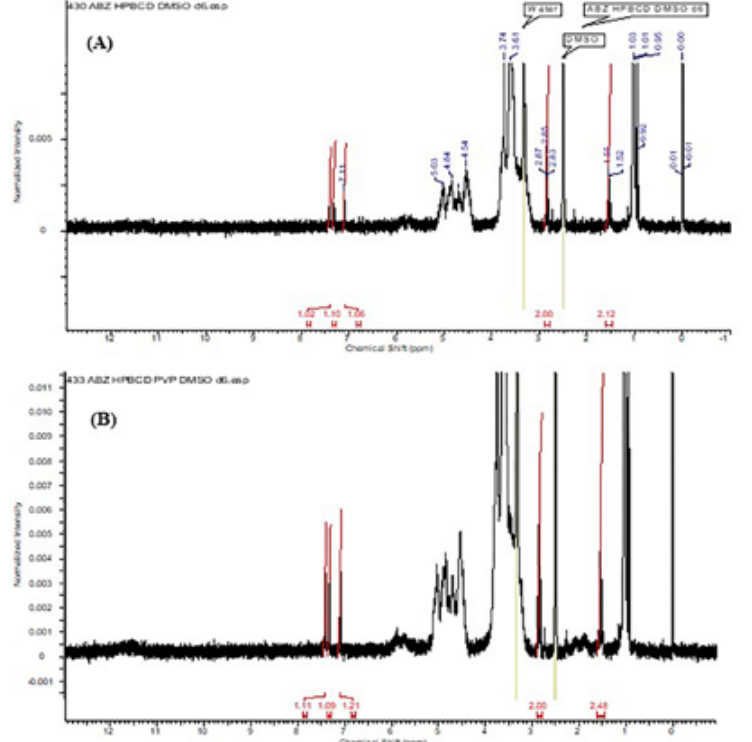
FIGURE 4 - 1 H-NMR spectrum of ABZ in the presence of HPβCD (A) and the water-soluble polymer (PVP) (B) recorded in 300 MHz